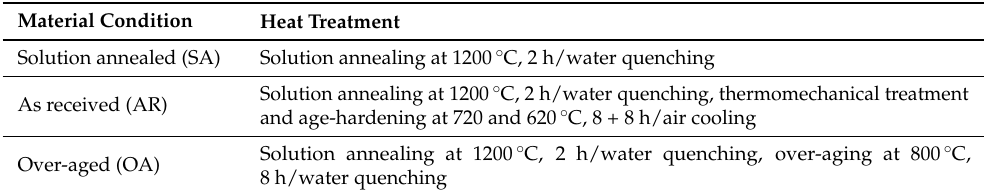
Table 1. A summary of the different heat treatments applied to the Ni-based superalloy 718 used in this study.